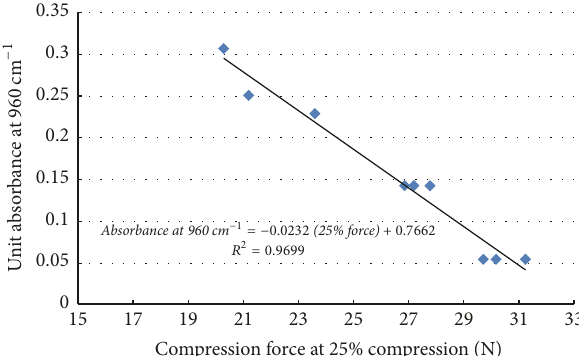
Figure 10: Correlation between compression force at 25% compres- sion and absorbance at 960 cm −1 during 96 hr of storage at room temperature (23 ∘